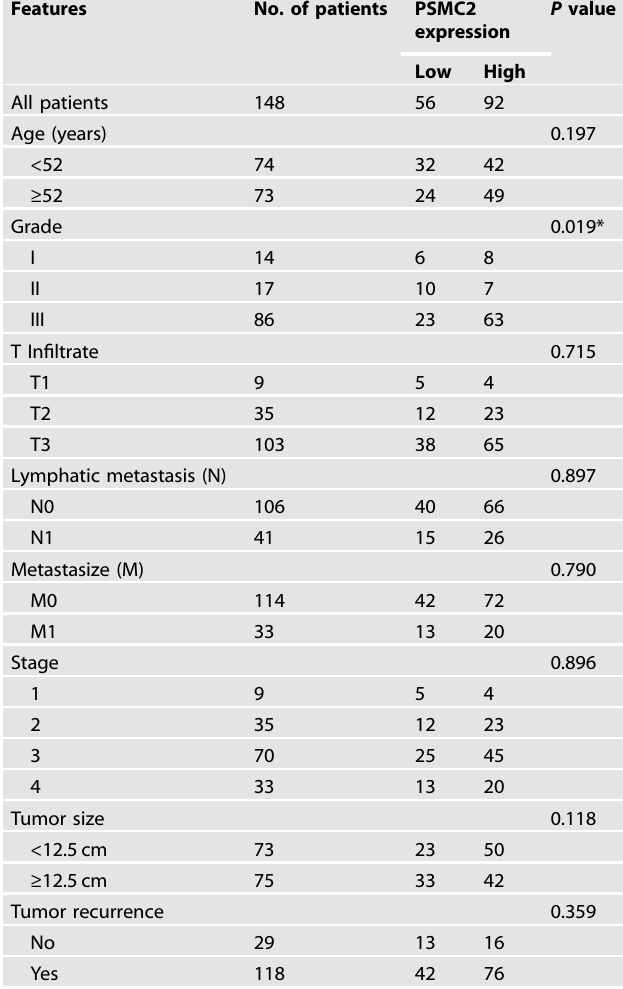
Table 2. Relationship between PSMC2 expression and tumor characteristics in patients with ovarian